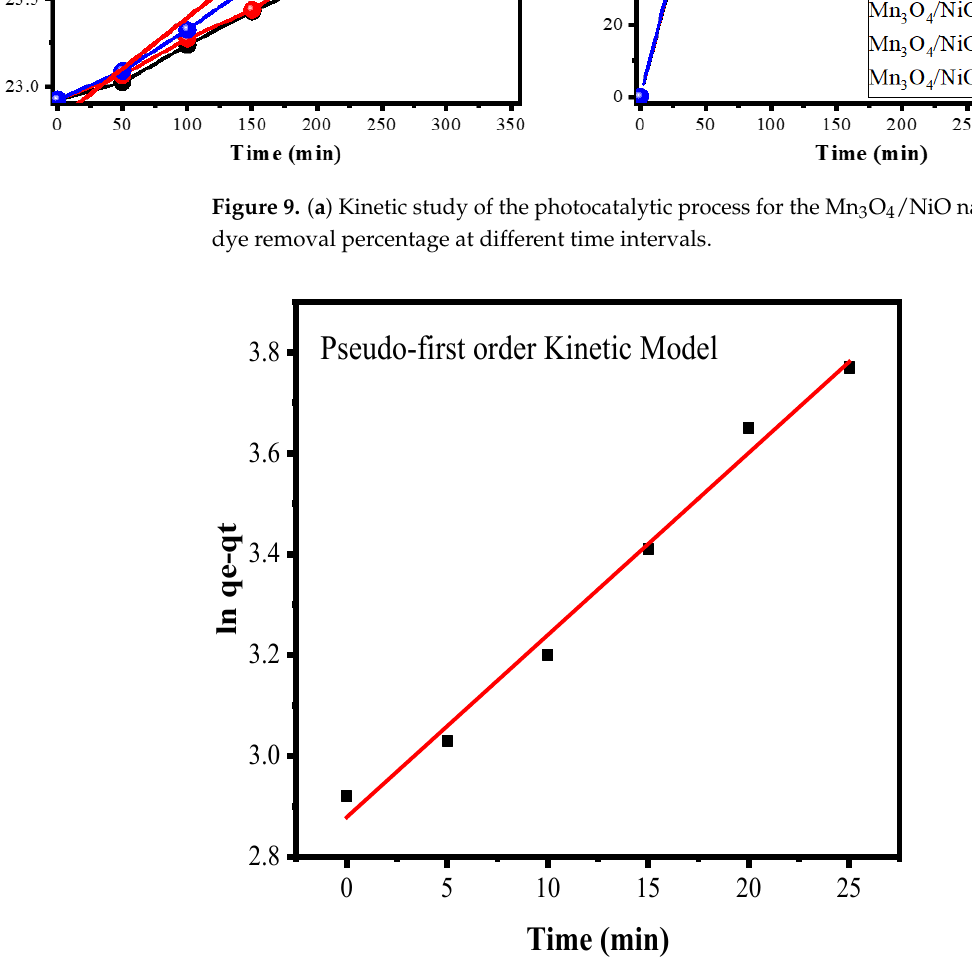
Table 2. Comparative study of the photodegradation efficiency of the proposed catalysts against reported photocatalysts in the literature.